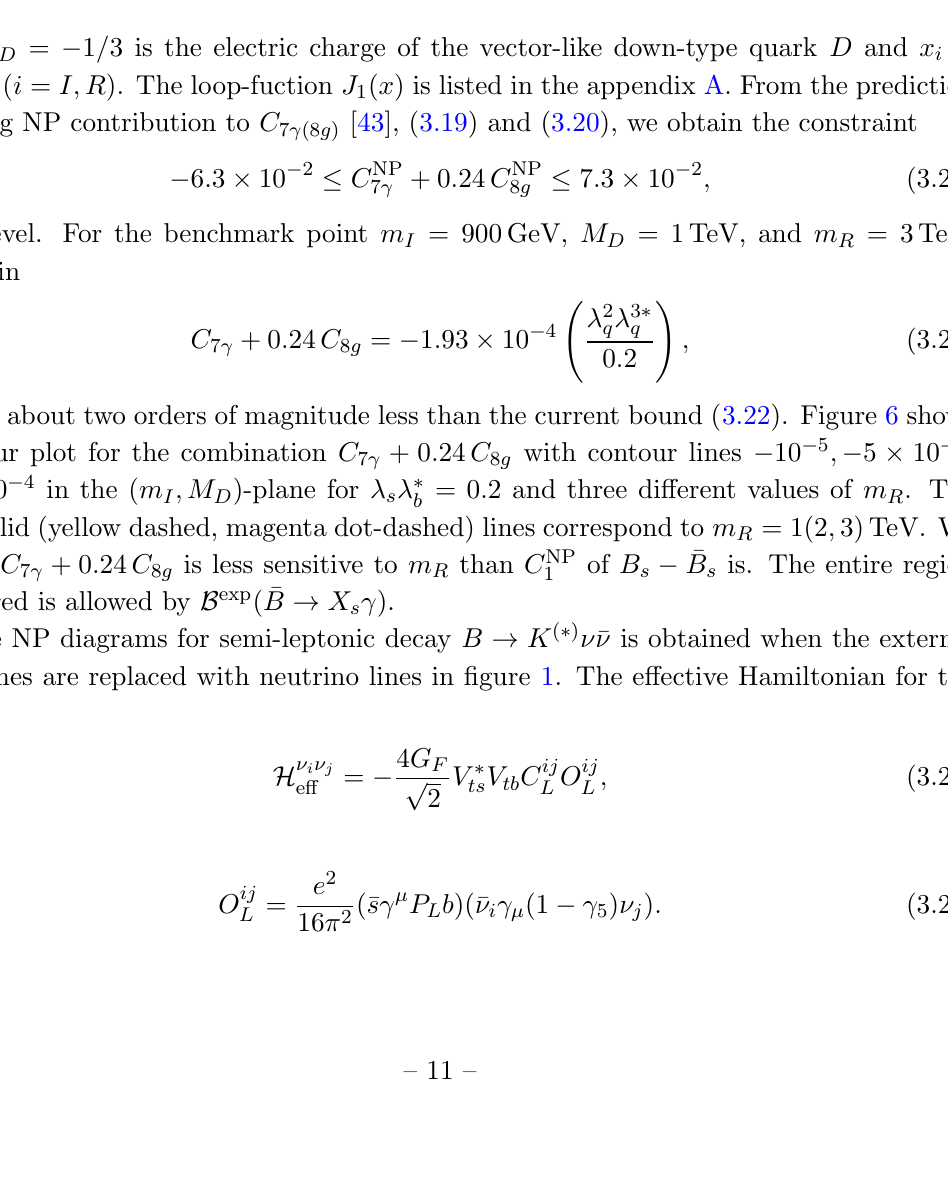
= 0 : 2 and three di(cid:11)erent values b